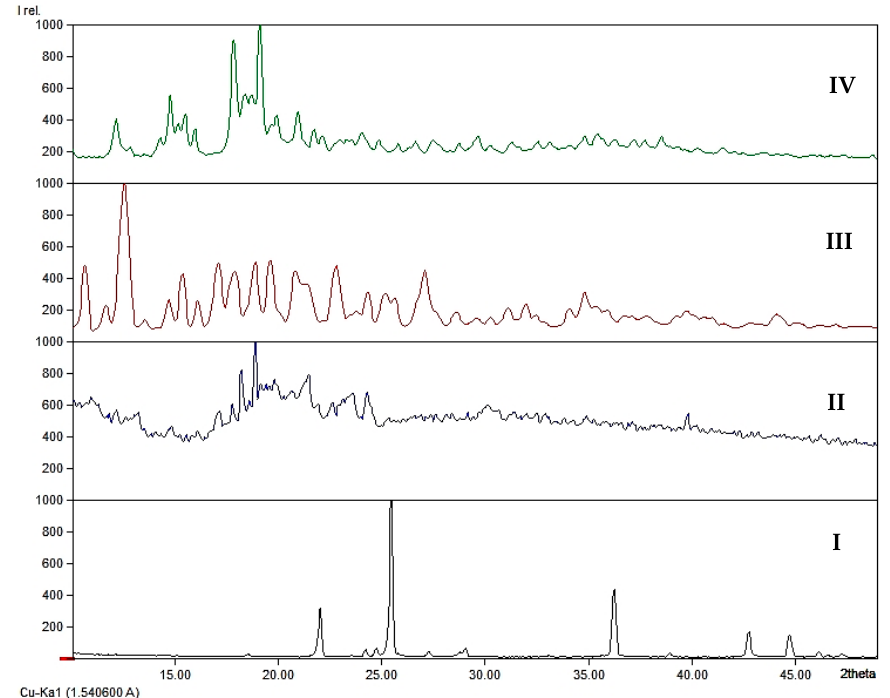
Figure 1. XRD spectra for ( I ) the stoichiometric mixture of KI and I 2 ; ( II ) the stoichiometric mixture of KI, I 2 and β -CD; ( III ) β -CD; ( IV ) iodine/ β -CD complex.